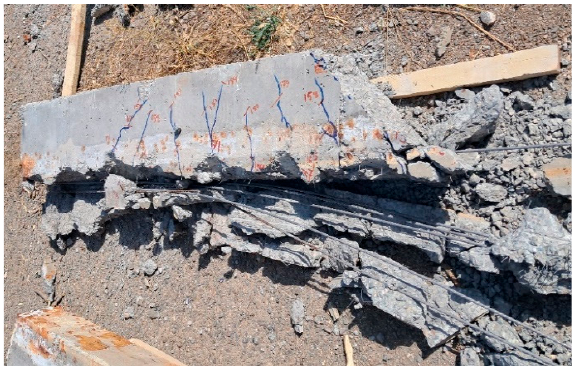
Figure 7. Destruction of specimens and removal of prestressing